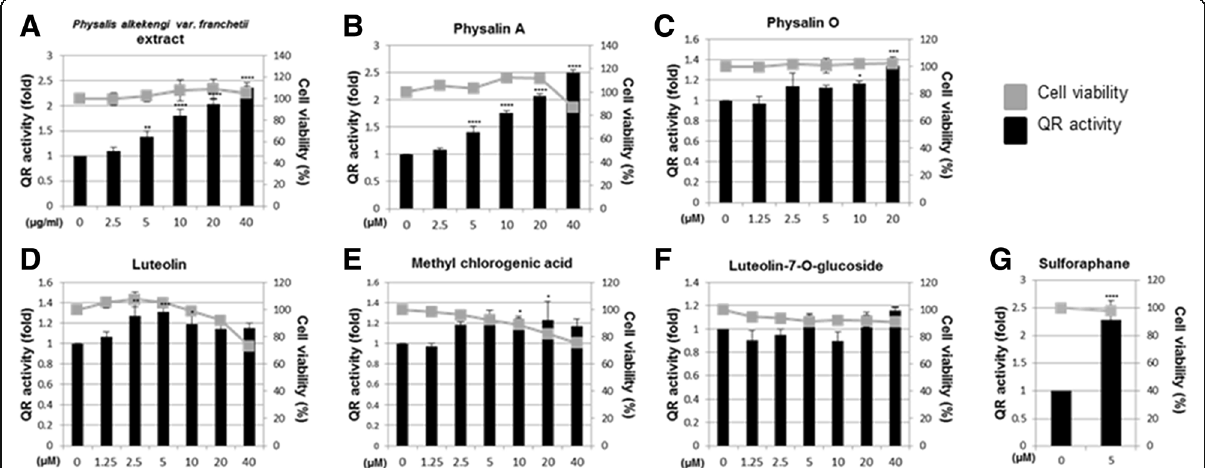
Fig. 3 Induction of QR-specific enzymatic activity in Hepa-1c1c7 cell line ( a ). QR assay and viability assay of Hepa1c1c7 cells treated with P. alkekengi ( b ) physalin A, ( c ) physalin O, ( d ) luteolin, ( e ) methyl chlorogenic acid, and ( f ) luteolin-7-O-glucoside. ( g ) QR assay and viability assay of sulforaphane-treated Hepa-1c1c7 cells. The cells treated for 24 h with 5 μ M sulforaphane as a positive control. (*: p < 0.05, **: p < 0.01, ***: p < 0.001, ****: p <